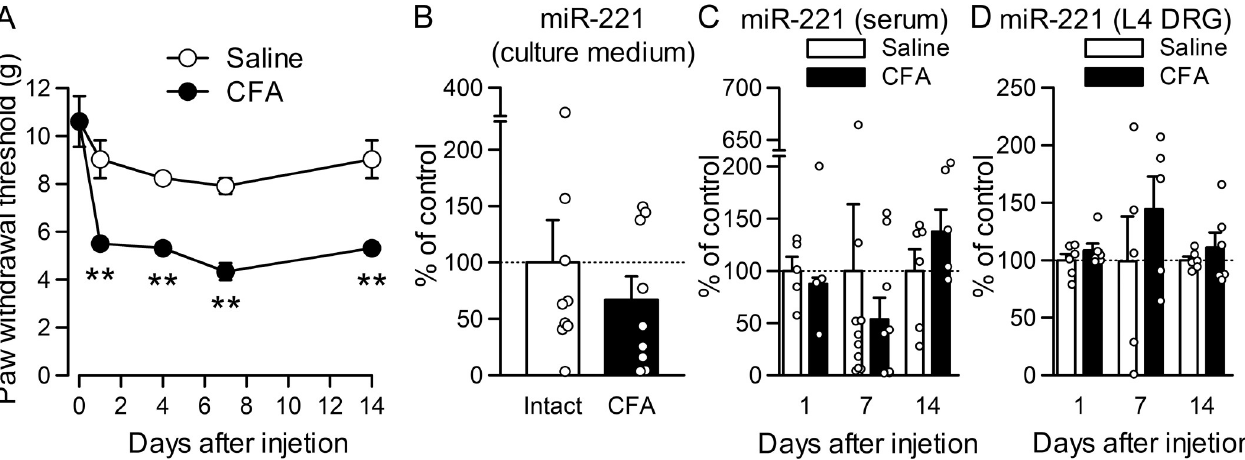
Fig 4. miR-221 levels after peripheral tissue inflammation induced by CFA. (A) Paw withdrawal responses to mechanical stimuli were evaluated before and after CFA or saline injection ( n = 6). �� P < 0.01, compared with saline injection (Mann–Whitney U -test). (B–D) miR-221 levels in the EVs obtained from culture medium obtained from L4-L6 DRGs on the injected side (B; n = 9) and serum (C; n = 9–10) and L4 DRG (D; n = 5).